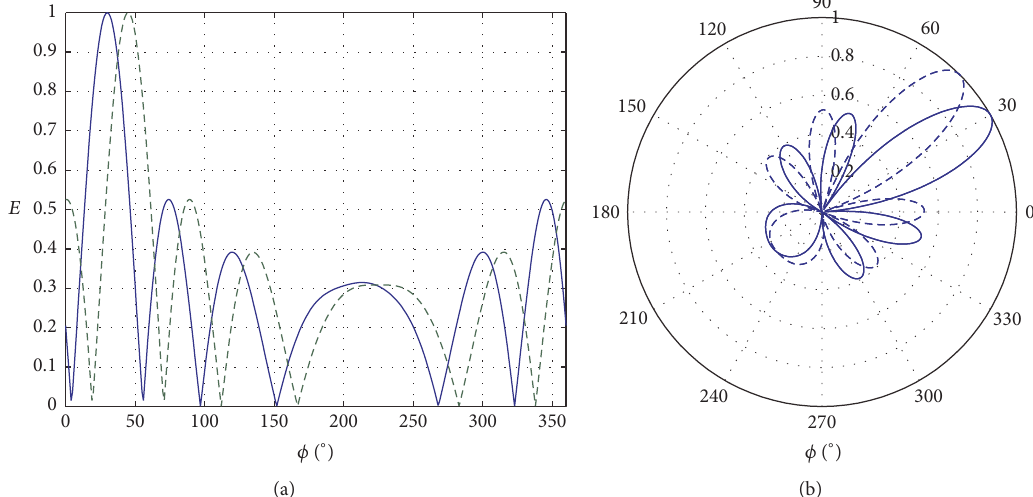
Figure 7: Pattern of 16-element circular array. (a) Normalized Cartesian coordinates. (b) Normalized polar diagram. ( 𝜃 = 45 ∘ , 𝜃 0 = 60 ∘ , ∘ (—)/45 ∘ (---)). 𝑅/𝜆 = 1: 1, and 𝜙 0 = 30